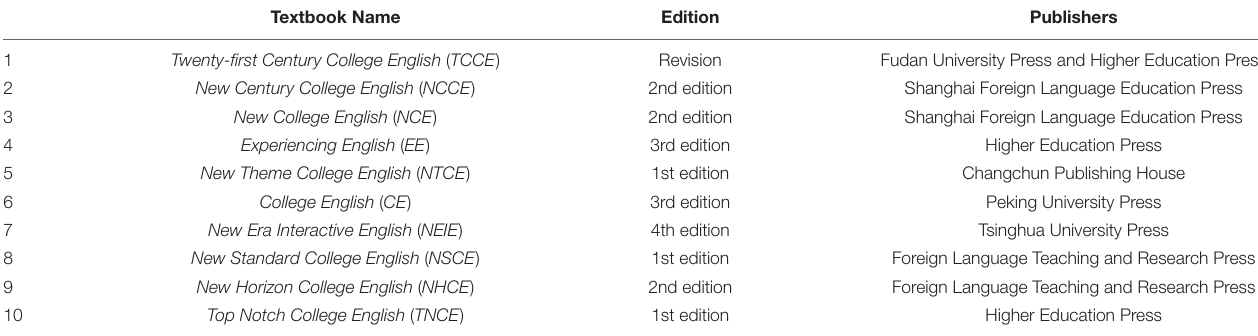
TABLE 1 | Ten series of English Language